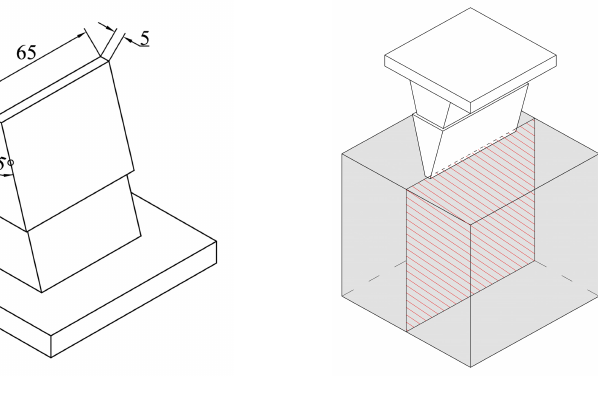
Table 1. Protodjakonow classification of the rocks and soils [14].